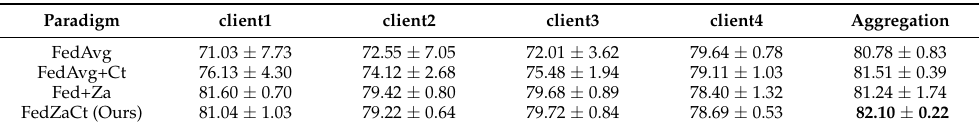
Table 3. Ablation results in the Federated paradigms. Based on Unet, the mean IoU values of ten repeated experiments on the private aortic